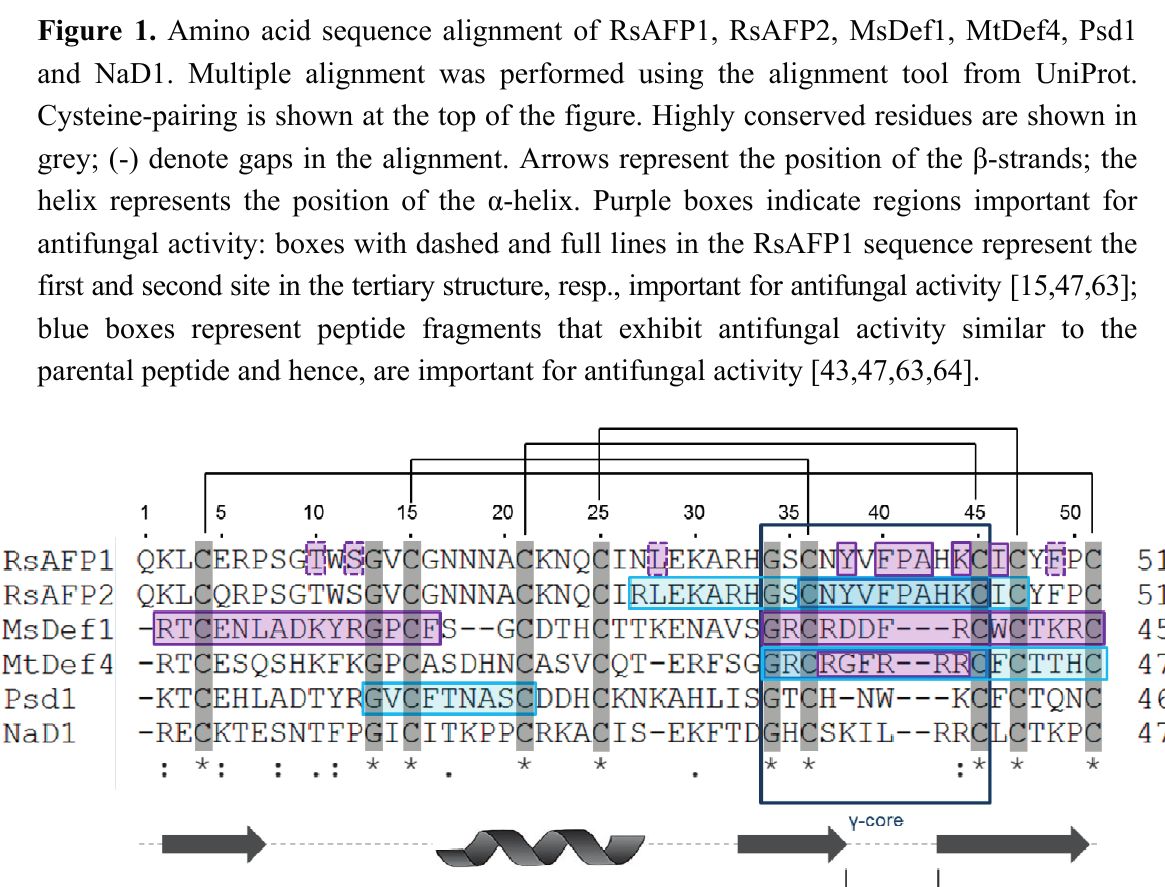
Figure 1. Amino acid sequence alignment of RsAFP1, RsAFP2, MsDef1, MtDef4, Psd1 and NaD1. Multiple alignment was performed using the alignment tool from